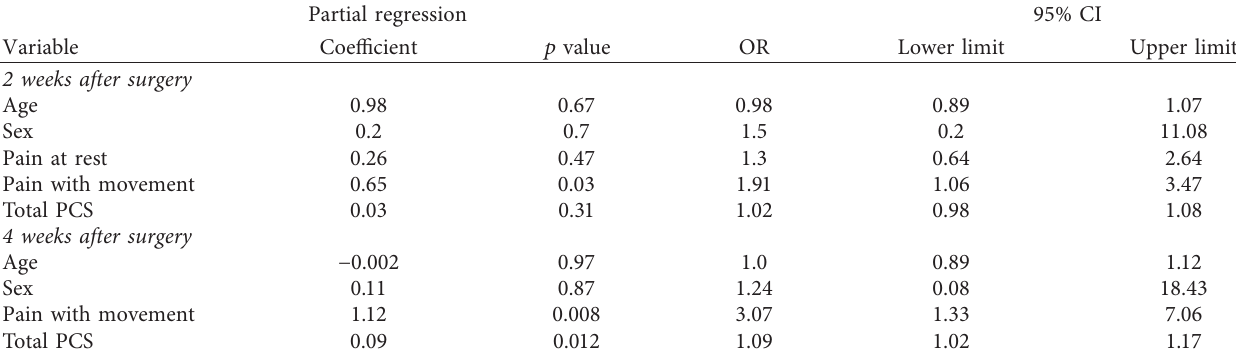
Table 4: Factors affecting persistent postoperative pain at 2 weeks and 4 weeks after HF surgery. Partial